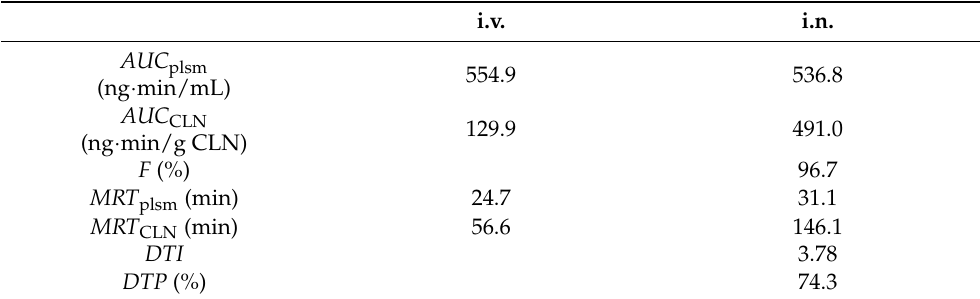
Table 1. Areas under the concentration–time curves and associated parameters following intravenous and intranasal